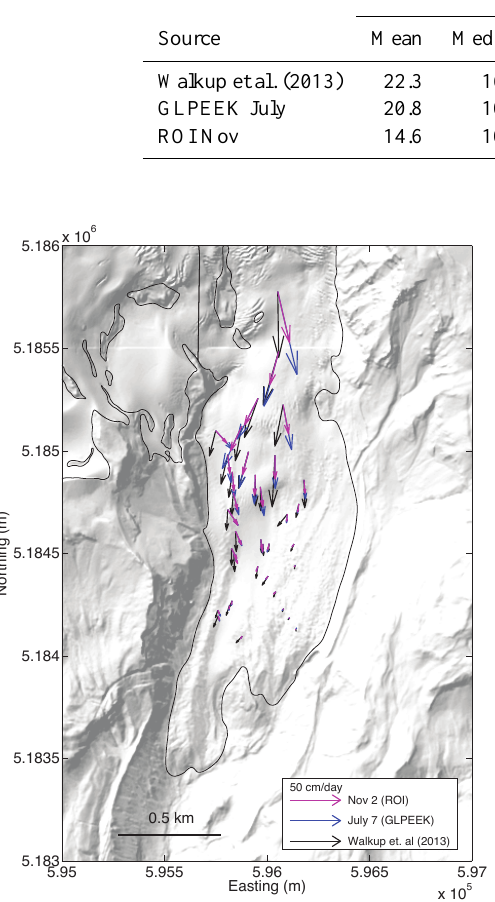
Figure 8. Comparison of average azimuth and velocities measured by Walkup et al. (2013) between 19 July and 11 October 2012 (black) compared to TRI slope-parallel velocities derived from this study at the same locations for two time periods that bracket the time period measured by Walkup et al. (2013). See Table 4 for com- parison statistics and Box C in Fig. 1 for